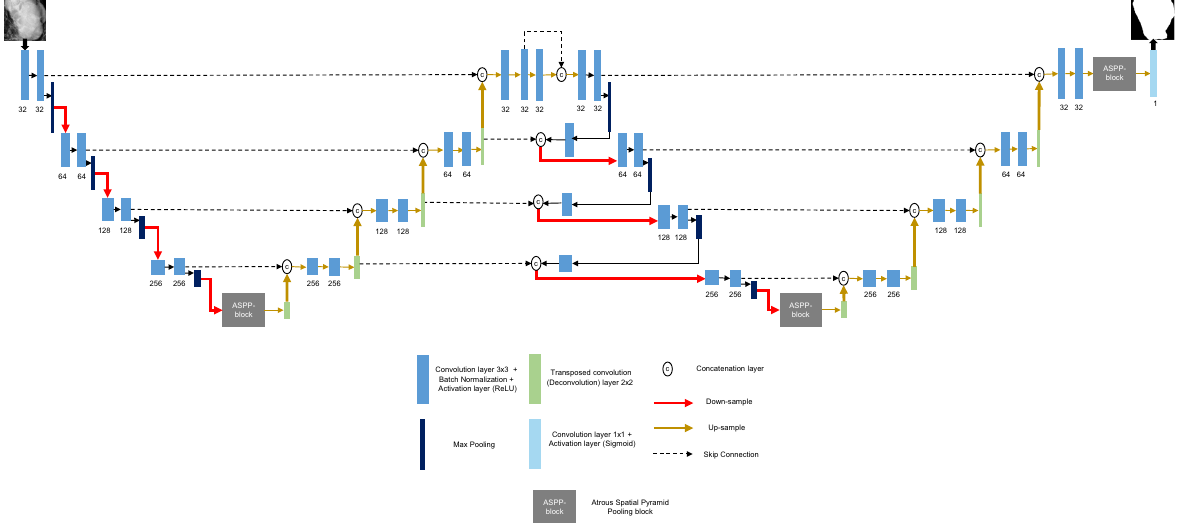
Fig. 8 The proposed Connect-UNets architecture. Architecture shows two cascaded encoders (i.e. down-sample pathway) (red arrows) and decoders (i.e. up-sample pathway) (yellow arrows), all alternately connected via skip connection (i.e. dashed lines) and ASPP blocks. An input image is fed to the fi rst block, and a segmentation (binary) image is returned by the last block. Encoders are represented by Convolution layer + Batch Normalization (blue blocks), and Activation layer (dark blue blocks). Decoders are represented by Transposed convolution (green blocks), and Convolution layer + Activation layer (light blue